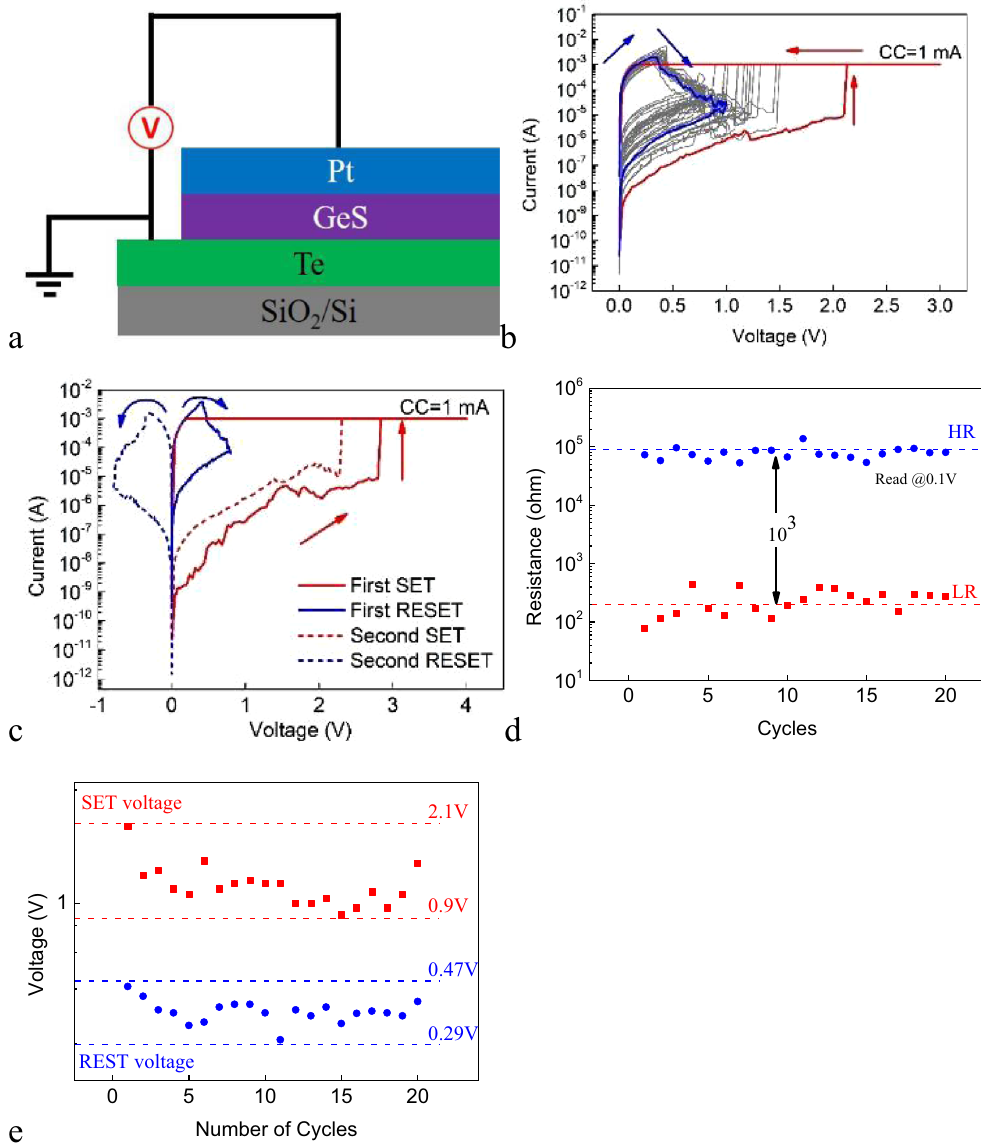
Figure 7. ( a ) The schematic structure of the Pt/GeS/Te cell. ( b ) The DC I-V curves of 20 consecutive sweep cycles for the Pt/GeS/Te cell under the SET CC of 1 mA. ( c ) The DC I-V curves of the sweeping only in one direction and in both directions for the Pt/GeS/Te cell. The SET CC is 1 mA. ( d ) The statistical distribution of the SET voltage and RESET voltage for the Pt/GeS/Te cell. ( e ) The LR and HR of the Pt/GeS/Te cell for 20 consecutive sweep cycles. The voltage of read pulse is 100